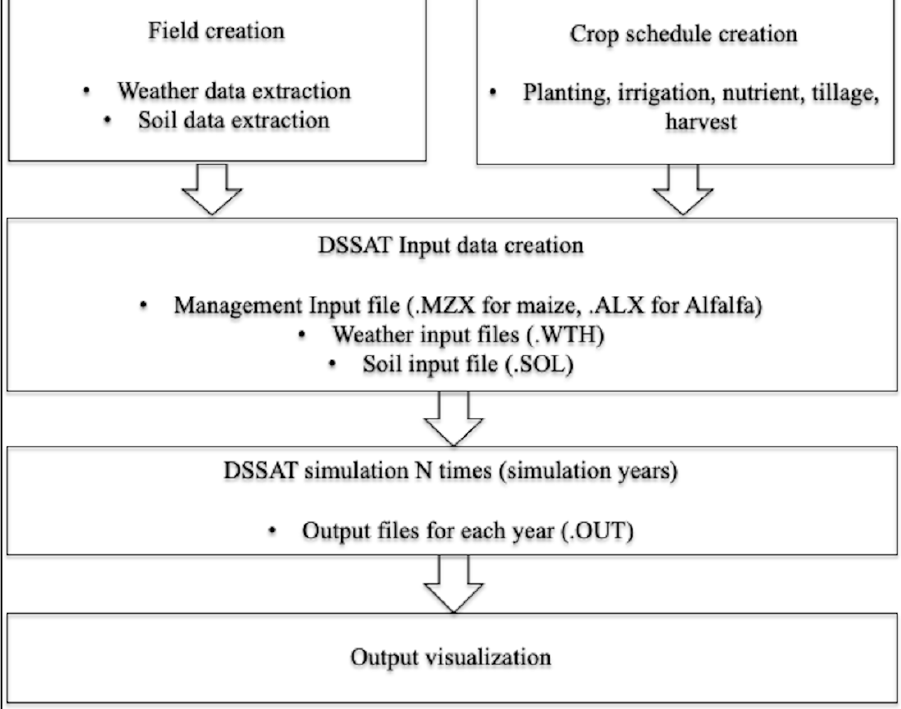
Figure 3. Flowchart for the FARMs web app.